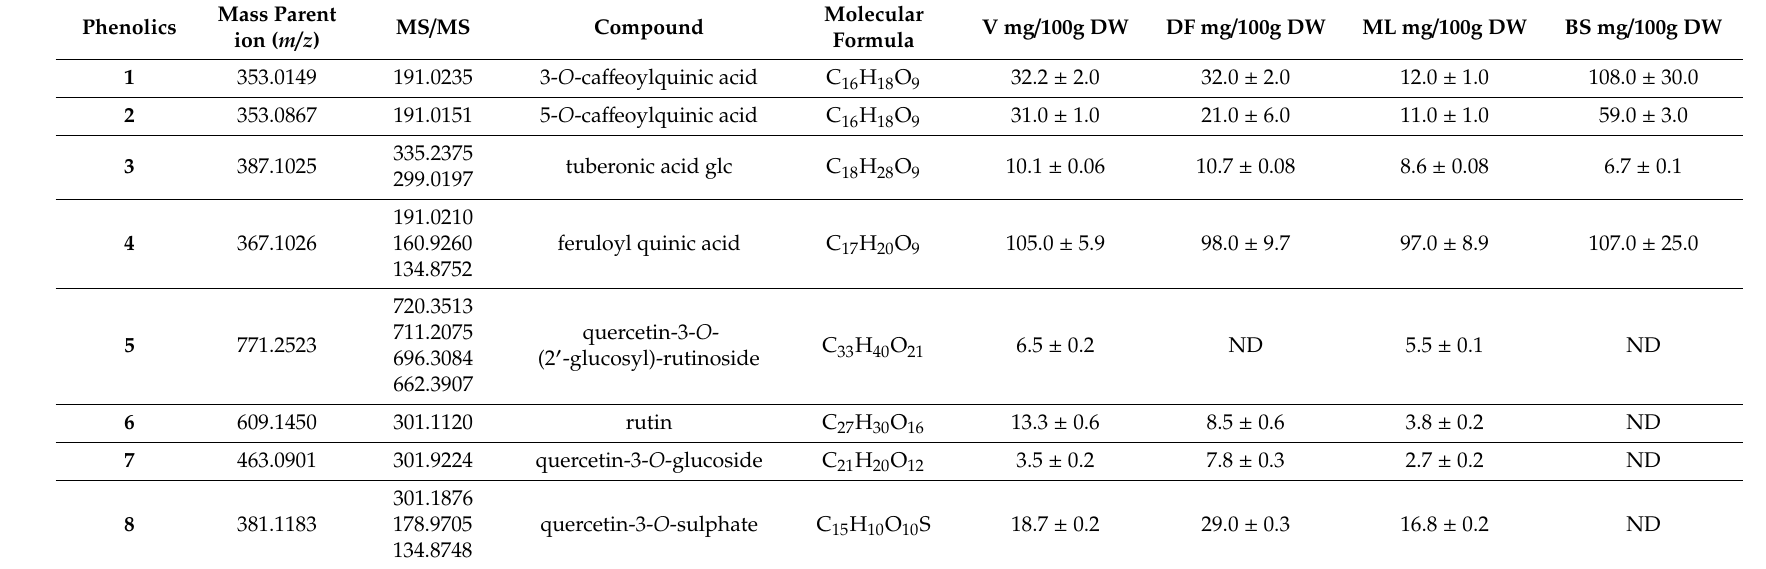
Table 1. High-resolution (HR) MS and MS / MS data of phenolic compounds in LC-ESI-Orbitrap-MS profiles of the PAE from the four Solanum tuberosum